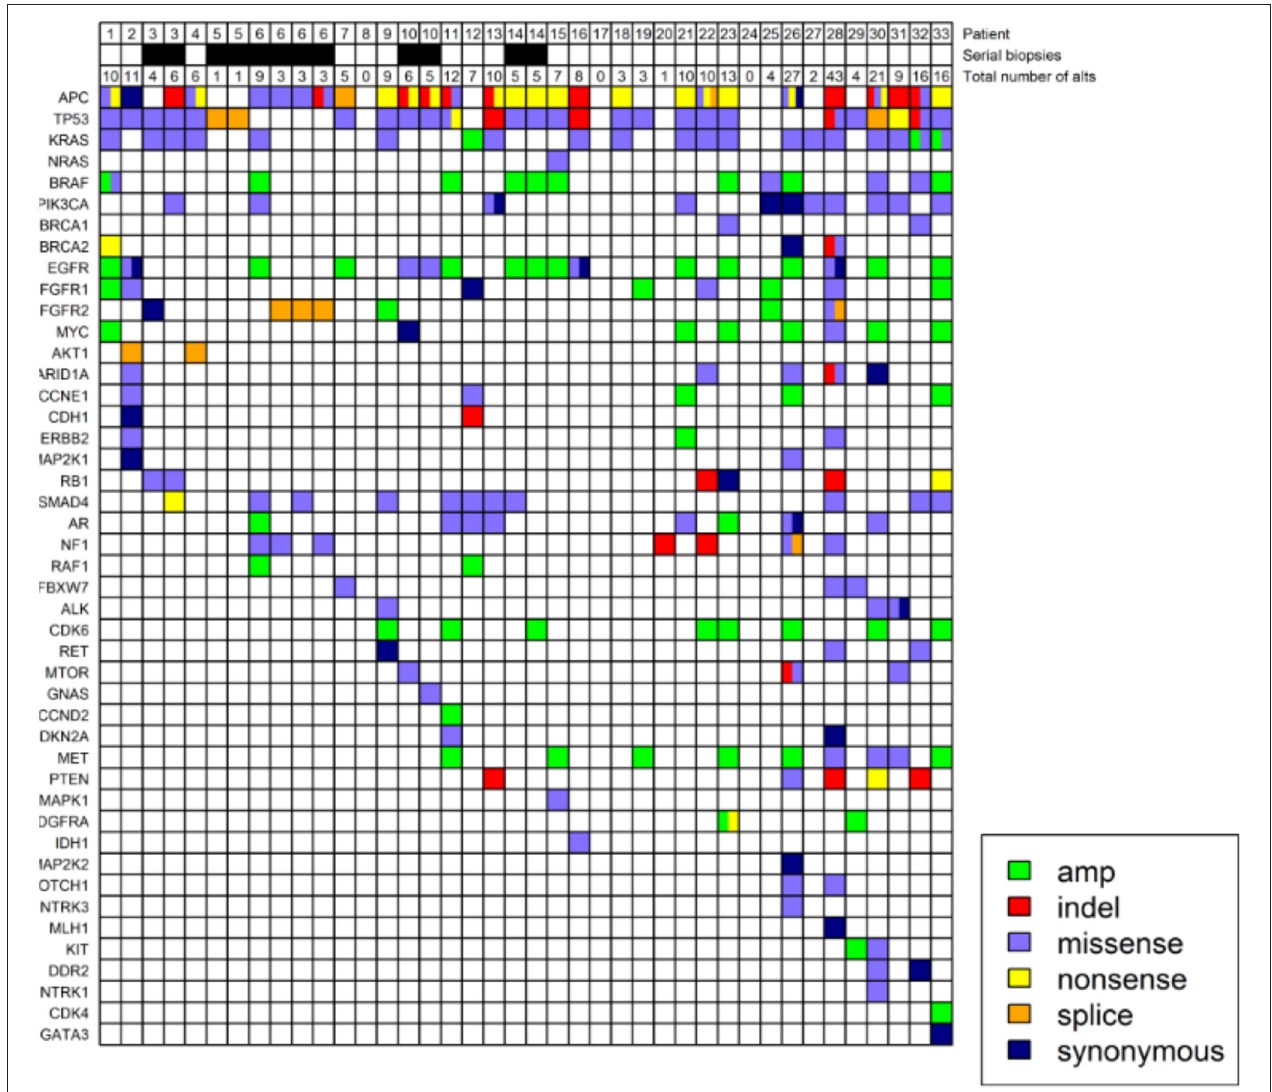
FIGURE 1 | Genomic profiling of circulating free tumor DNA in 33 patients with metastatic colorectal cancer. Four patients underwent serial LB as indicated in the second row. The number of alts detected on LB are listed in the third row. Colors denote different types of alts. Allele frequencies associated with the alts can be found in Supplementary Table 1